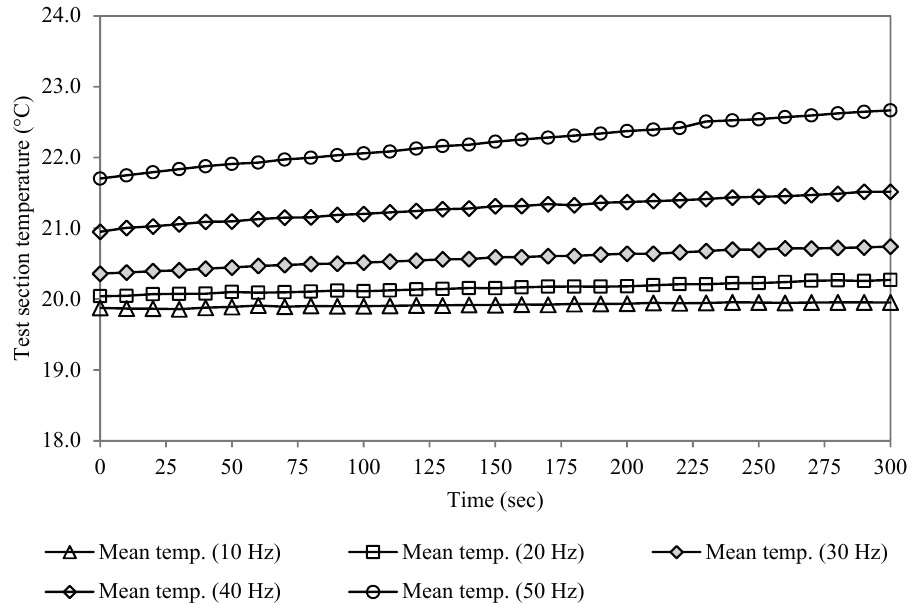
Figure 11. Mean test section temperatures at increasing fan frequencies without heating elements.